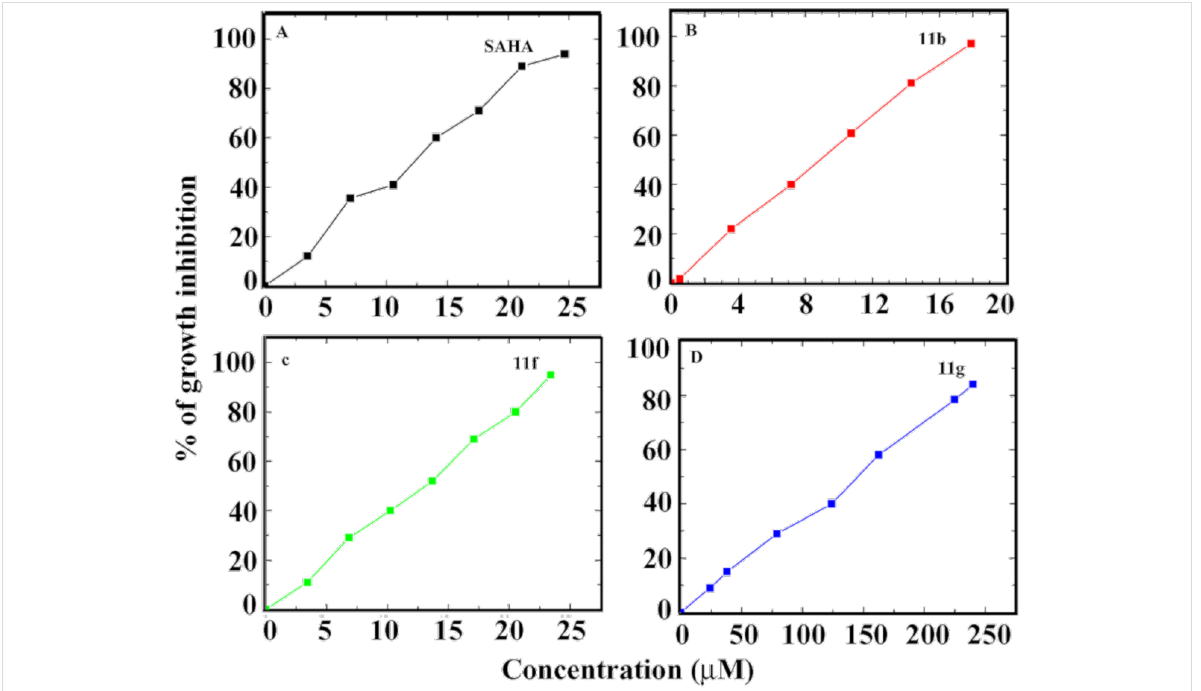
Figure 2: Cell viability from MTT assay for SAHA , 11b , 11f and 11g on HeLa after 24 h treatment.